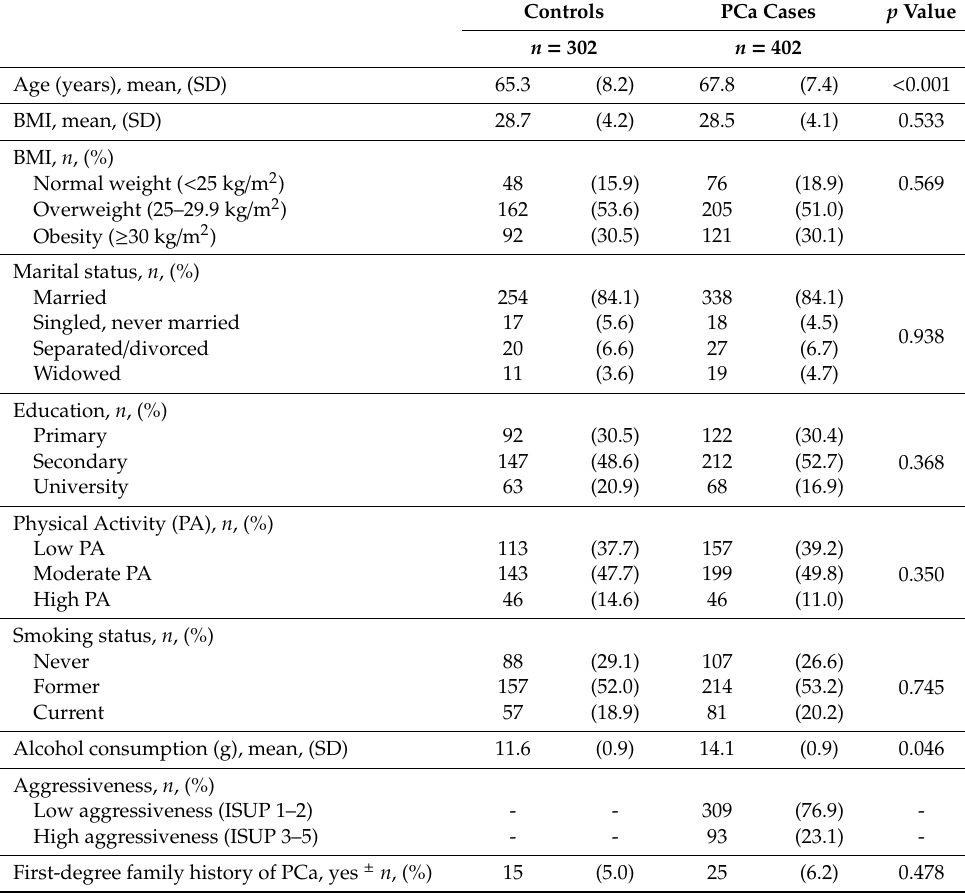
Table 2. Characteristics of the controls and PCa cases in the CAPLIFE